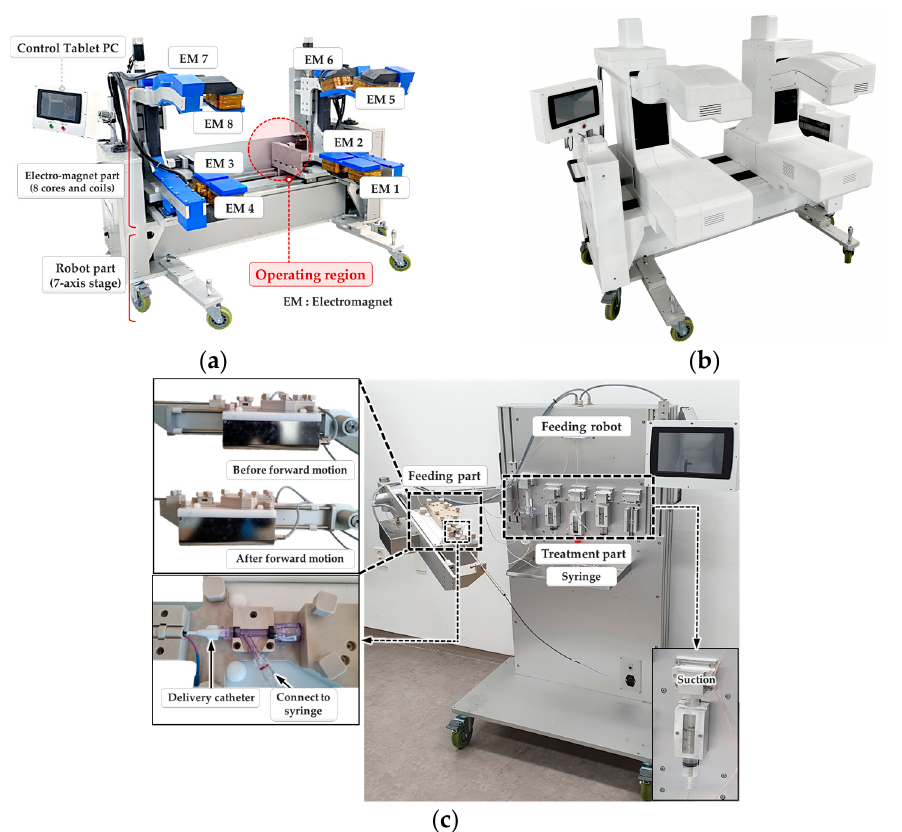
Figure 2. I-RAMAN system: ( a ) structure of the MNS; ( b ) the MNS with exterior housing; ( c ) structure of the feeding robot.